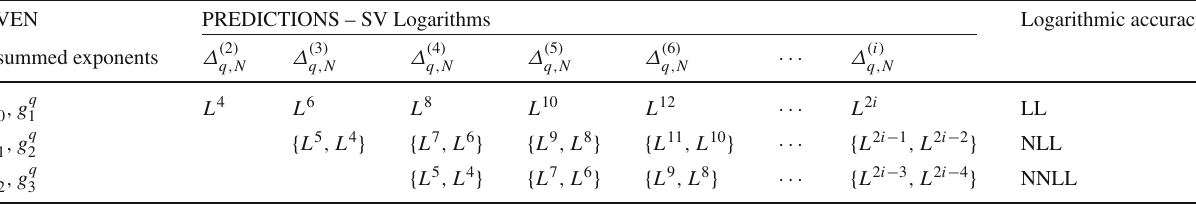
(cid:18) (cid:17) , g q (ω) ˜ g q which is required to predict the tower of SV logarithms in Δ q , N at a given logarithmic n 0 , n